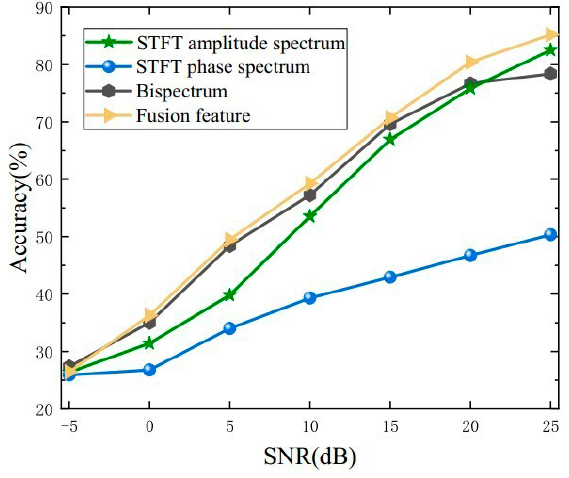
Figure 6. Feature recognition results of the method proposed by Zhang et al. [29] at different signal- to-noise